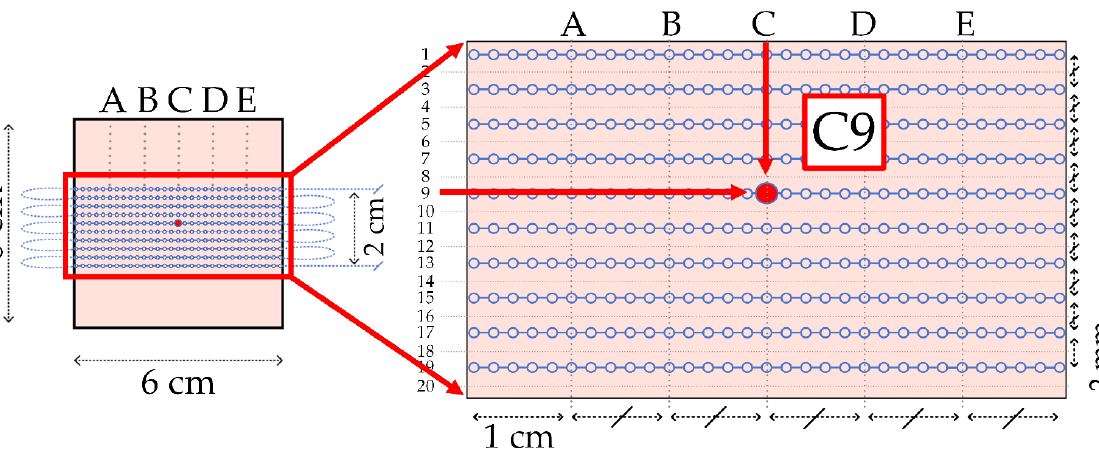
Figure 6. Graphical illustration of ten fiber lines embedded in silicone material. Vertically, the fiber lines are divided in 5 points of investigation, spaced 1 cm between each other, tagged as A, B, C, D, E. Horizontally, the investigation lines are spaced of 1 mm tagged from 1 to 20. Horizontally, the investigation lines are spaced of 1 mm tagged from 1 to